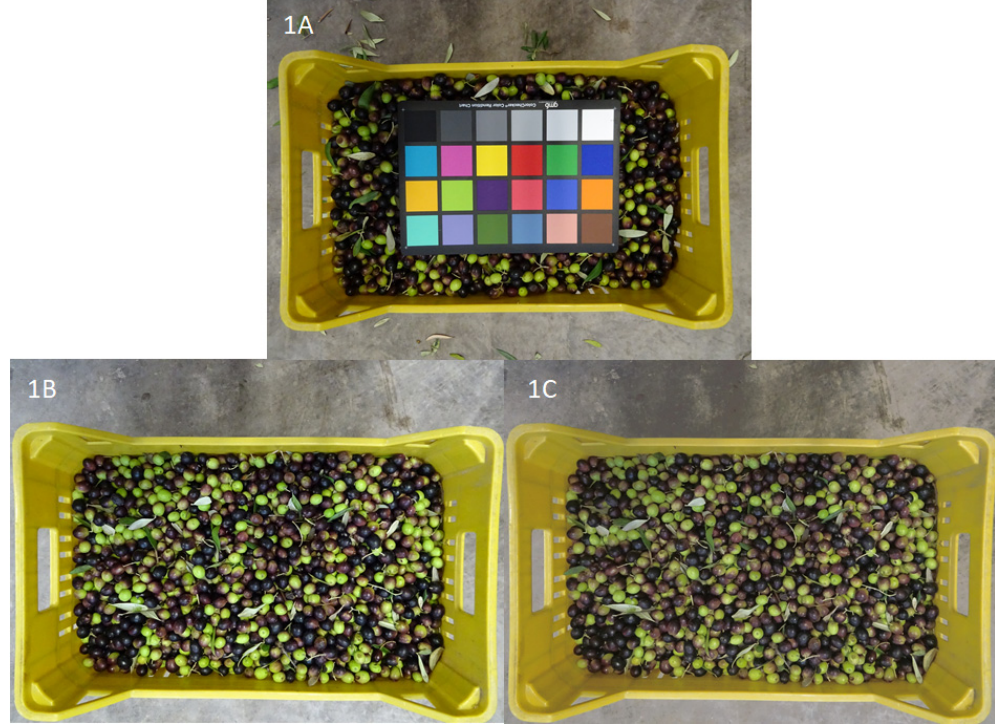
Figure 1. ( A ) Color checker GretagMacbeth (24 patches) within the olive tray; ( B ) original acquired image of olive tray; ( C ) resulting calibrated image of olive tray.